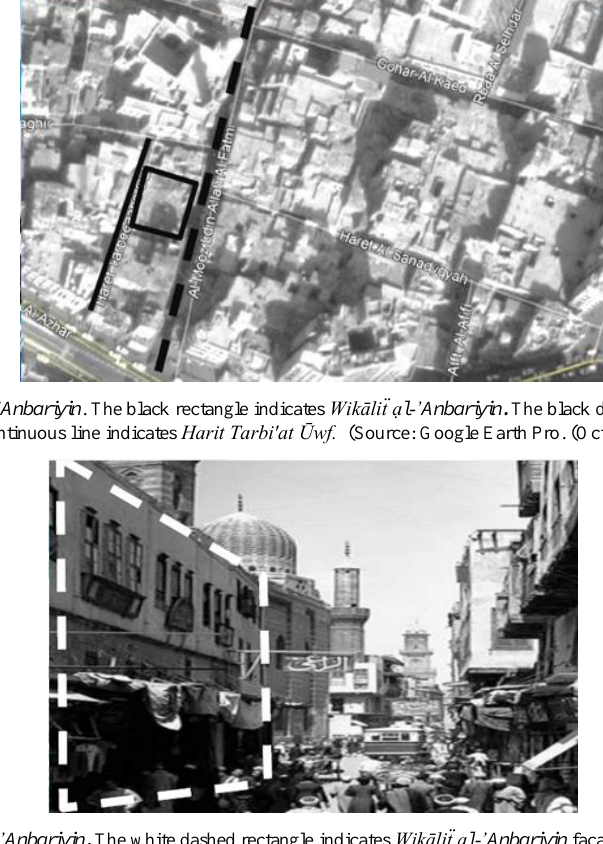
Figure 2. Location of Wikāliẗ ạl - ’Anbariyin. The white dashed rectangle indicates Wikāliẗ ạl - ’Anbariyin façade and its shops which overlook ạl- Muʿiz Street. The white dashed line indicates the attached building. (Source: